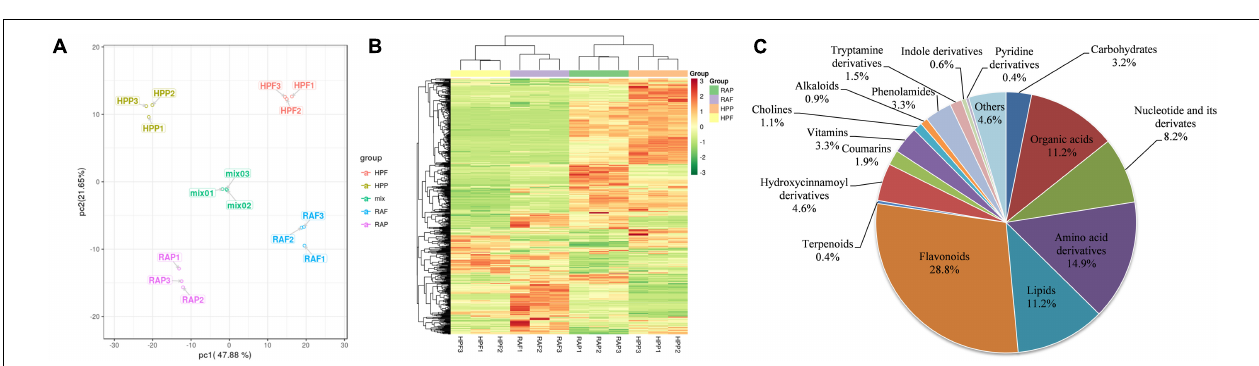
FIGURE 1 | Quality characteristics of RA and HP fruits. (A) Fruit photograph. (B) Total flavonoid content. (C) Single fruit weight. (D) Pericarp thickness. (E) Oil gland number. (F) Cuticle microscopic morphology. Asterisks indicate the significant difference between two verities ( ∗ P < 0.05, ∗∗ P < 0.01, and ∗∗∗ P < 0.001).